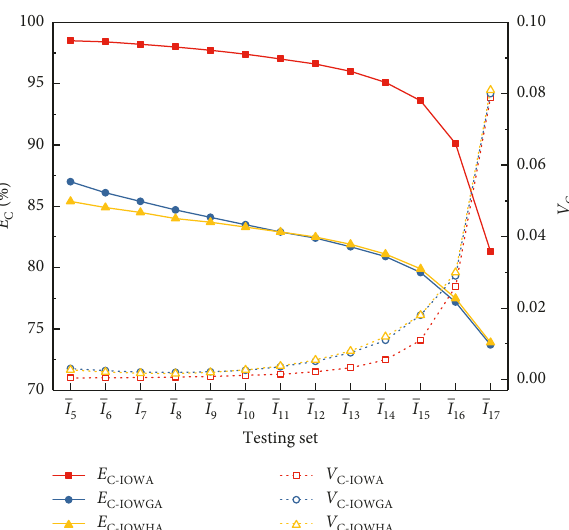
Figure 14: Curves of E C and V C of testing sets.